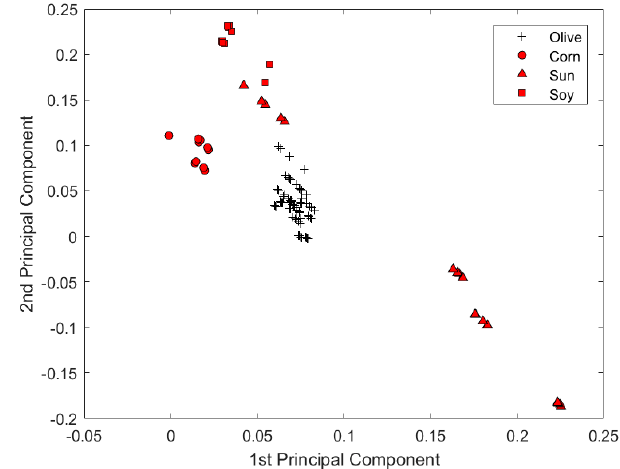
Figure 7. The principal component scores plot of quality assessment between extra virgin olive oils and other vegetable oils by the microtiter plate reader.